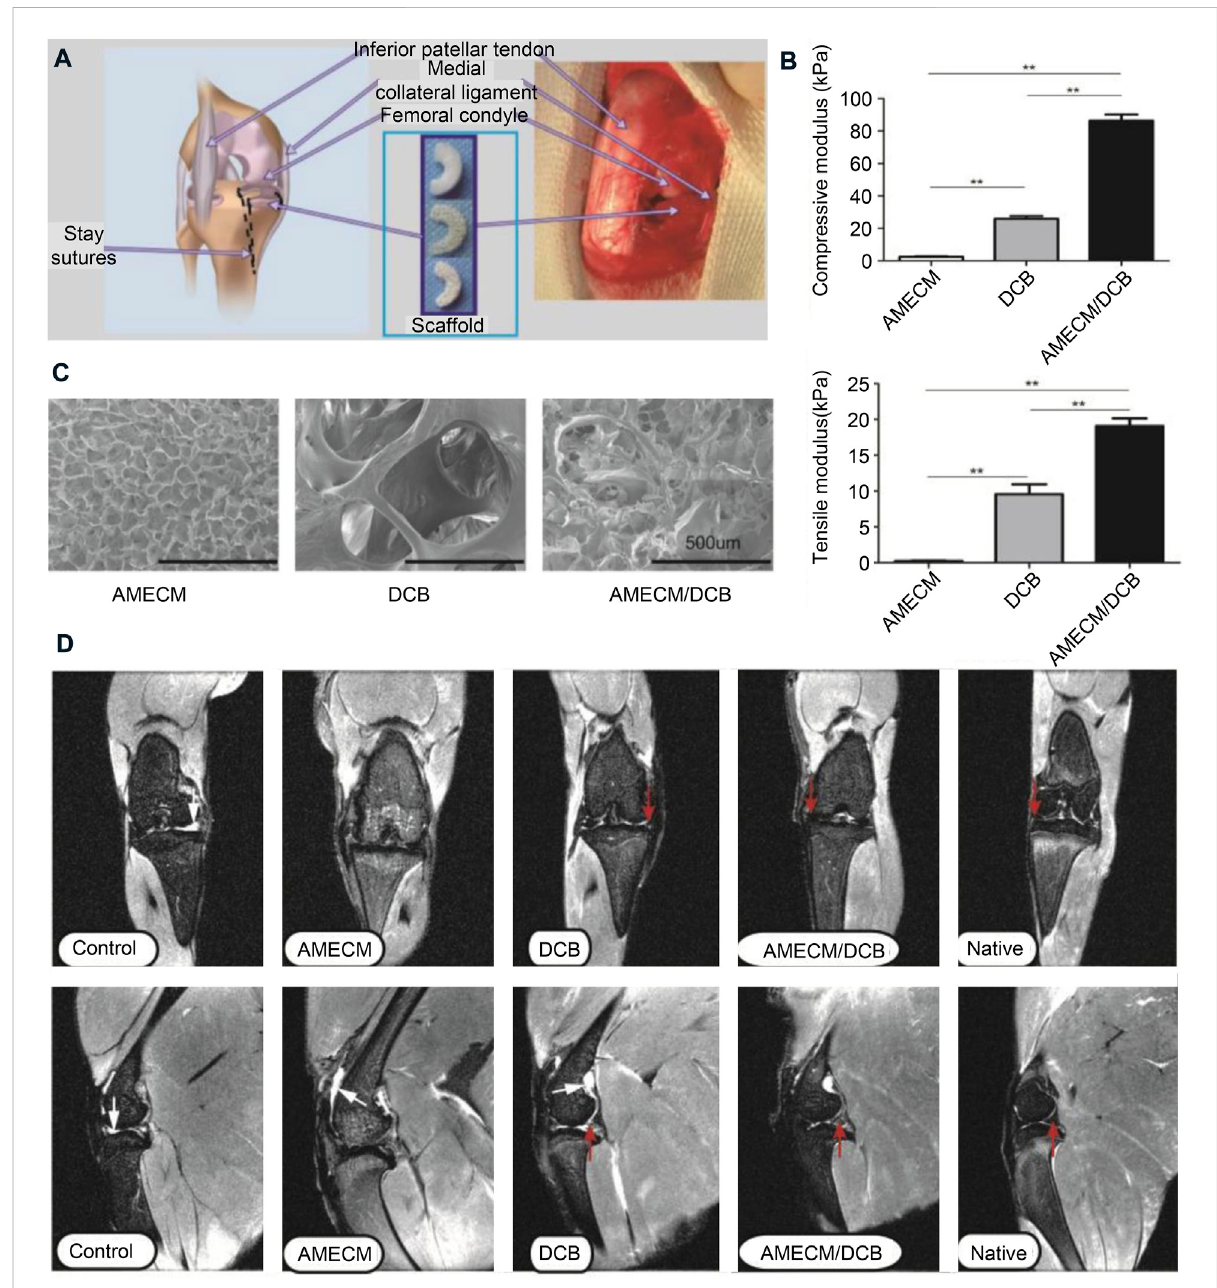
FIGURE 7 Extracellular matrix used for meniscus tissue engineering. (A) Surgical strategies for repairing meniscus with extracellular matrix scaffolds. (B) Comparative mechanical modulus of the different scaffolds. (C) Scanning electron micrographs of the different scaffolds. (D) Magnetic resonance imaging (MRI)of rabbitknees6 months after surgery. The redarrow indicatestheregeneratedmenisci. Reprintedwith permission (Yuanetal.,2016). Copyright (2016),